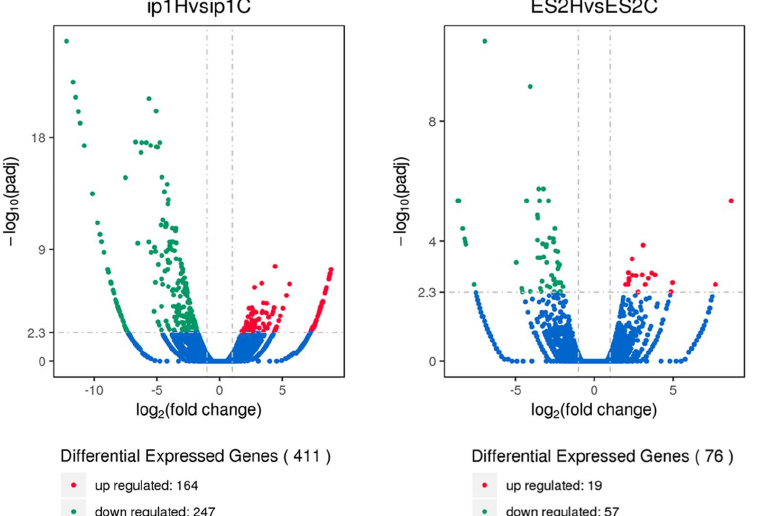
Figure 5. Volcano diagram of differential expression genes in paired tumors treated with HCFs and the control tumor not treated with films. Tumor tissues were obtained from the control (ip1C) and HCFs with 1216 μm pores (ip1H) in SKOV3ip1 cells, and from the control (ES2C) and HCFs with 58 μm pores (ES2H) in ES2 cells. The horizontal axis represents the fold change of genes in different samples. The vertical axis represents the statistically significant degree of changes in gene expression levels, the more significant the difference, and the smaller the corrected p -value, the bigger −log10 (corrected p -value). The point represents a gene, blue dots indicate no significant difference in genes, red dots indicate upregulated differentially expressed genes, and green dots indicate downregulated differentially expressed genes.